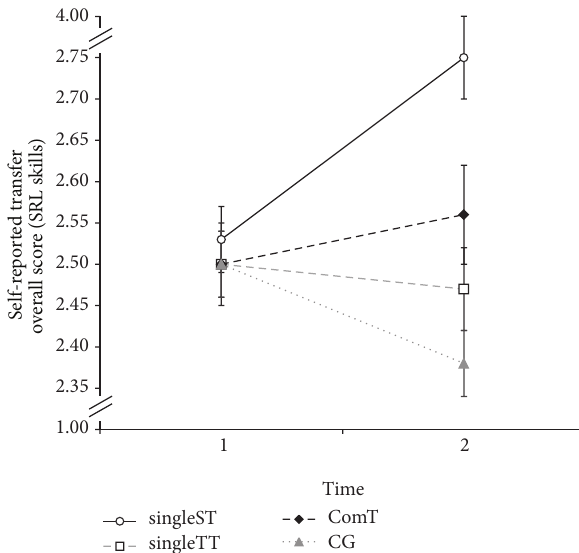
Figure 2: Depiction of the interaction ST × IT × time for the self- reported transfer on self-regulated learning (SRL). singleST (single student training: 𝑁 = 43 ); singleTT (single teacher training: 𝑁 = 48 ); ComT (combined training: 𝑁 = 33 ); CG (control group: 𝑁 = 123 ). 1 = pretest, 2 = posttest.